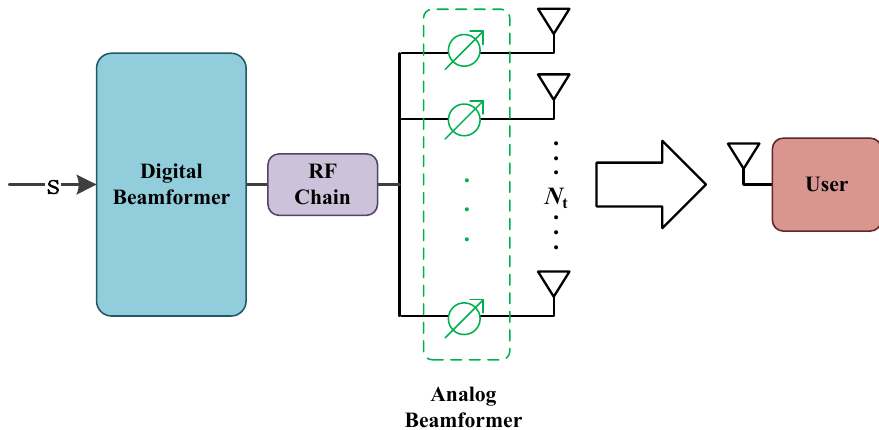
Figure 1. SU-MISO system architecture with hybrid (analog and baseband)